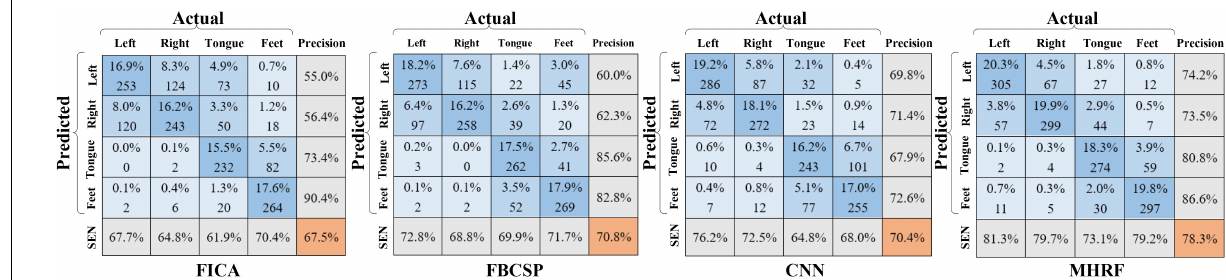
FIGURE 7 | Confusion matrices for the four methods (FICA, FBCSP, CNN, and MHRF).